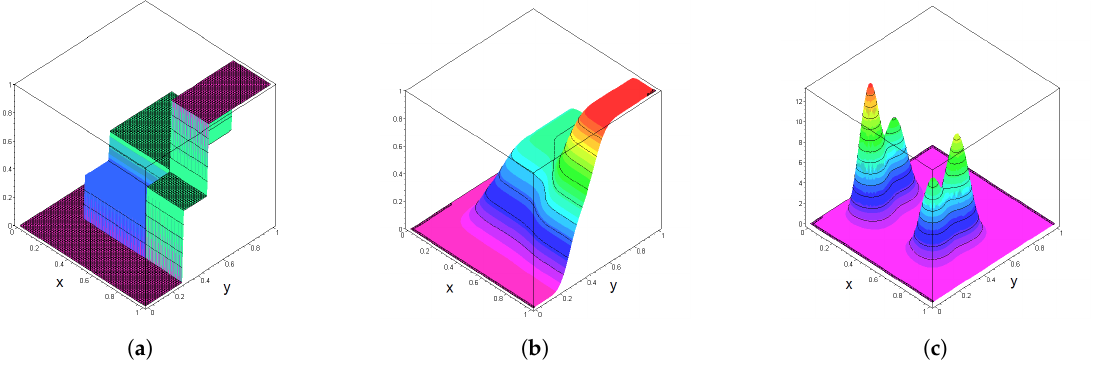
Figure 3. Plots of the functions in Example 2, n 1 . ( c ) Plot of b n F B n F x , y p q